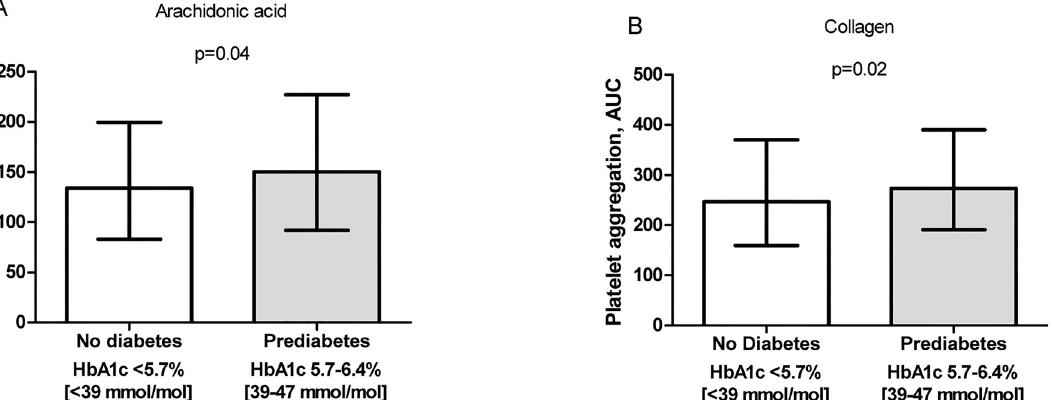
Fig 1. Platelet aggregation. Platelet aggregation in patients with coronary artery disease; 307 patients without diabetes (HbA1c < 5.7%) and 303 patients with prediabetes (HbA1c 5.7 – 6.4%). Platelet aggregation induced by A) arachidonic acid and B) collagen as agonists using Multiplate Analyzer. Median and interquartile ranges are indicated.